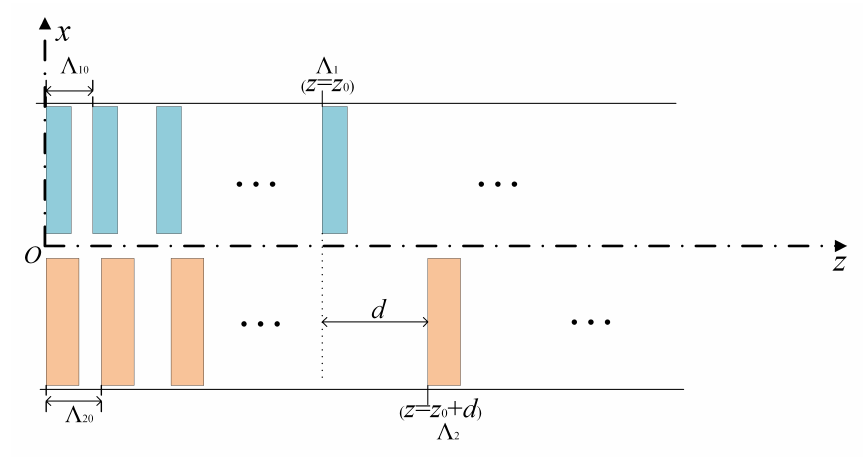
Figure 8. Schematic diagram of the resonant width for a 2D chirped fiber grating.